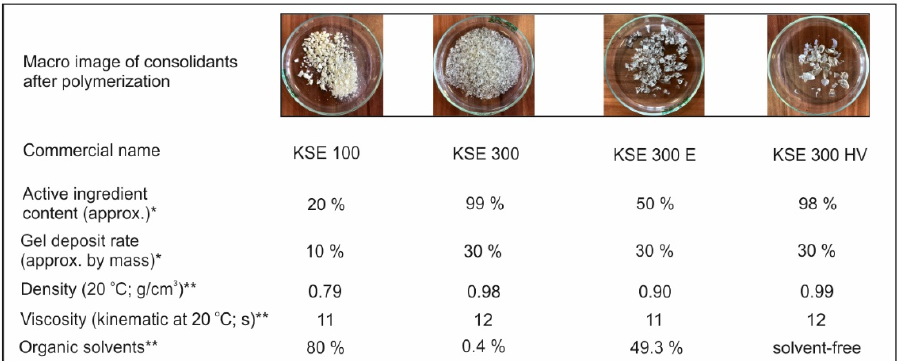
Figure 3. Micro-fabric of tested porous limestone, ( a )—fine-grained limestone from Sóskút (SF); ( b )—medium-grained limestone from Sóskút (SM); ( c )—medium-grained limestone from Fert ő rákos (FR).